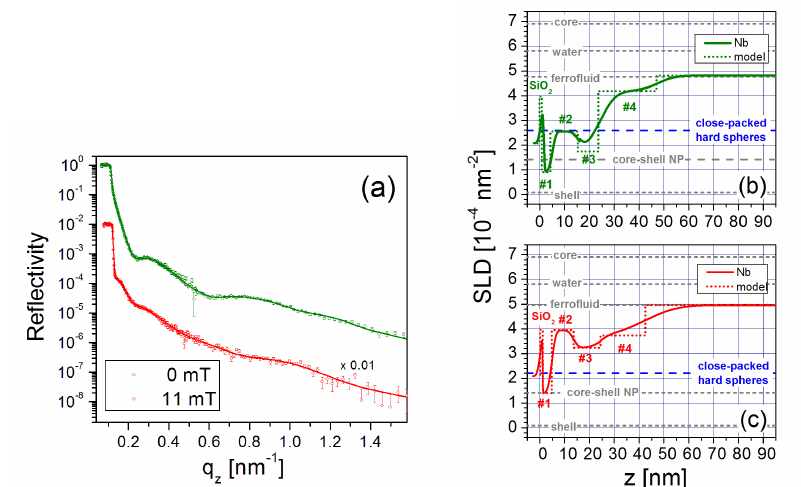
Figure 5. ( a ) NR data and fits (solid lines) for iron oxide nanoparticles on a hydrophilic Si/SiO 2 surface in fields of 0 mT and 11 mT. The latter data (red) are scaled by 0.01 for clarity. ( b , c ) Profiles of the nuclear SLDs as a function of distance z from the Si surface obtained from the model fits to the 0 mT and 11 mT NR data, respectively